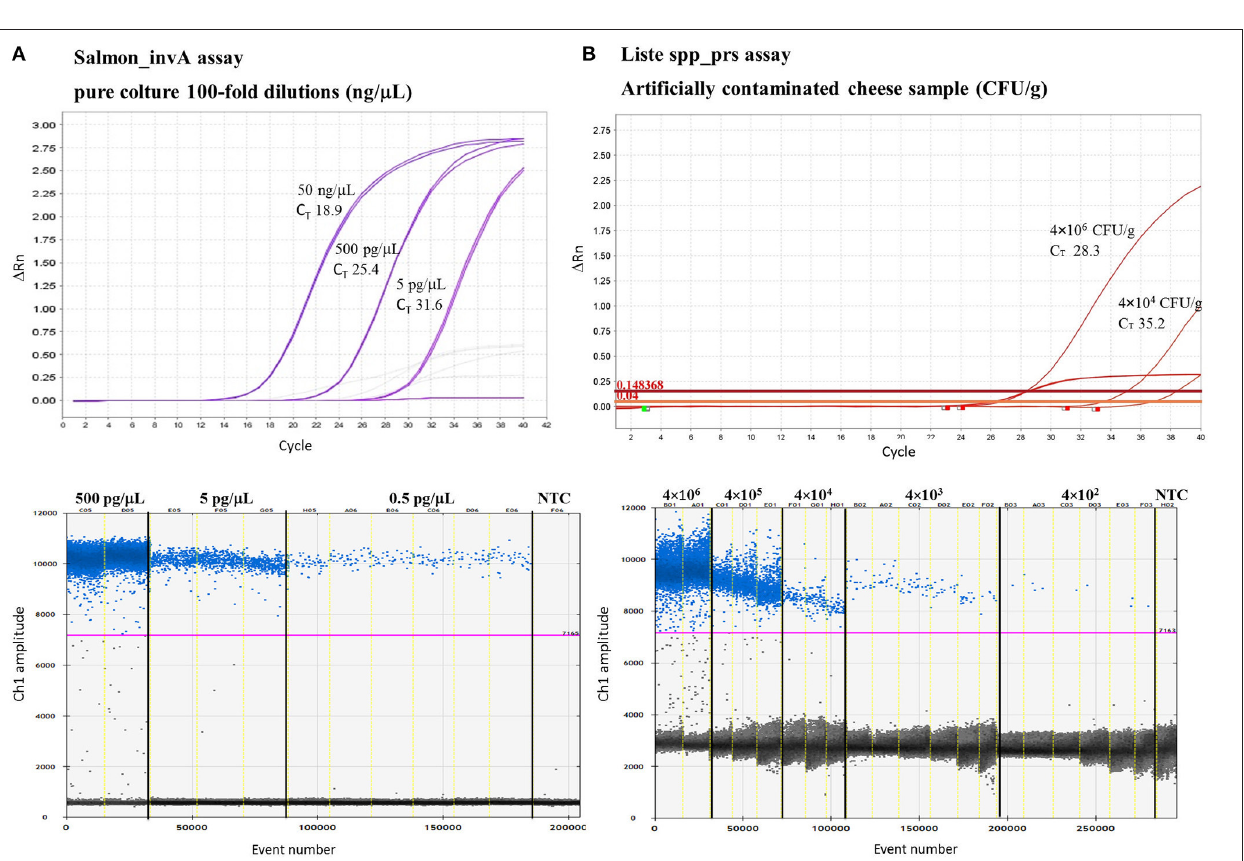
FIGURE 1 | Example of TaqMan TM assays analytical sensitivity by qPCR and ddPCR by using 100-fold dilution of DNA S. enteritidis SGSC2378 pure culture (A) and tenfold dilution of L. innocua 263651/13 in artificially contaminated soft cheese samples (B). For the qPCR (above) two replicates are shown while for ddPCR (1D Droplet Plots) up to six replicates were run with the lowest concentrations. NTC = negative template